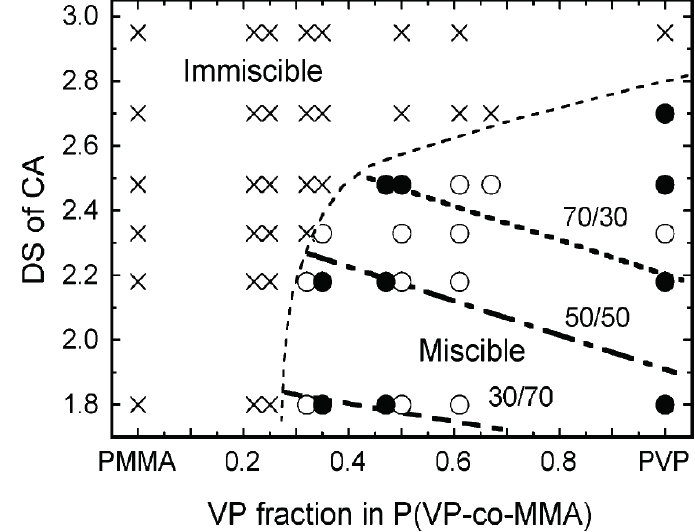
Figure 11. Miscibility map of the CA/P(VP- co -MMA) blend. Symbols indicate whether a given CA/P(VP- co -MMA) blend is miscible ( ○ and ● ) or immiscible (×). Closed circles represent the blend series used in the subsequent molecular orientation study. Three lines, designated as 70/30, 50/50, and 30/70, represent critical blend compositions. Miscible polymer combinations fitting the respective lines produce a birefringence-free material at the indicated critical composition. Reprinted with permission from ref. [40]. Copyright 2007 American Chemical